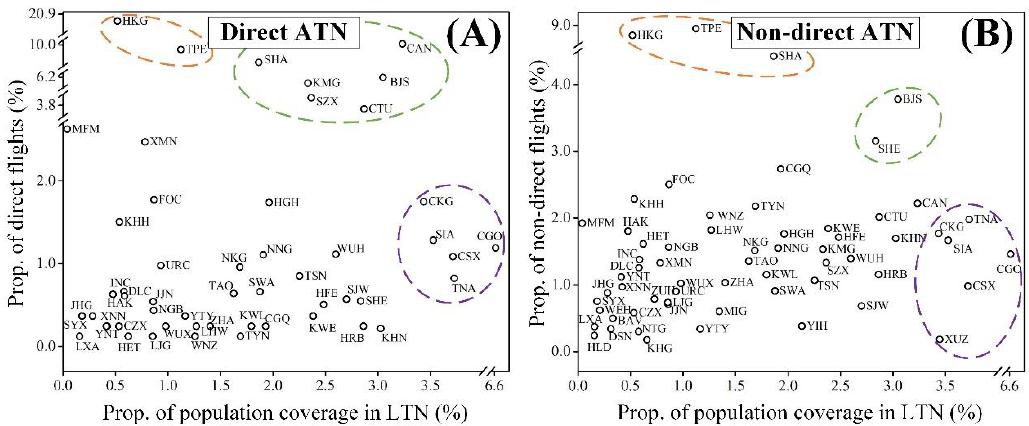
Figure 9. The relationship between proportion (prop.) of population to the nearest airport in LTN and the proportion of direct flights ( A ) and non-direct flights ( B ) to SA&SEA.